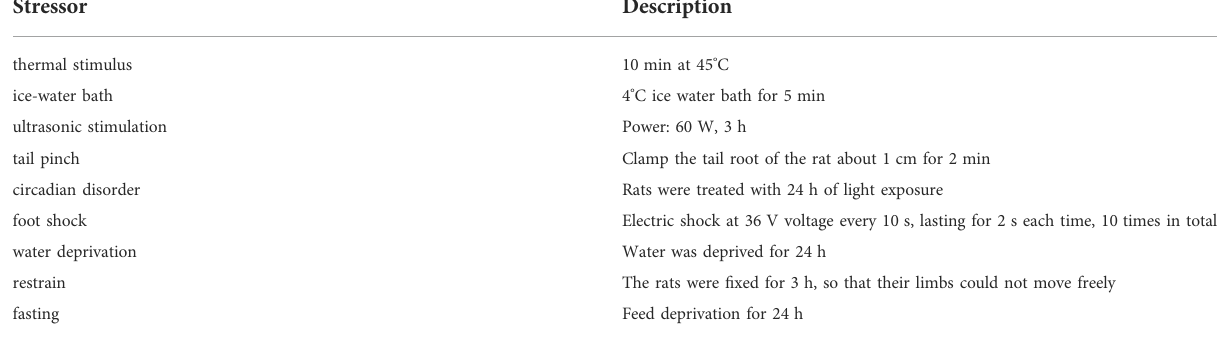
TABLE 1 Stressors used in the Chronic Unpredictable Stress